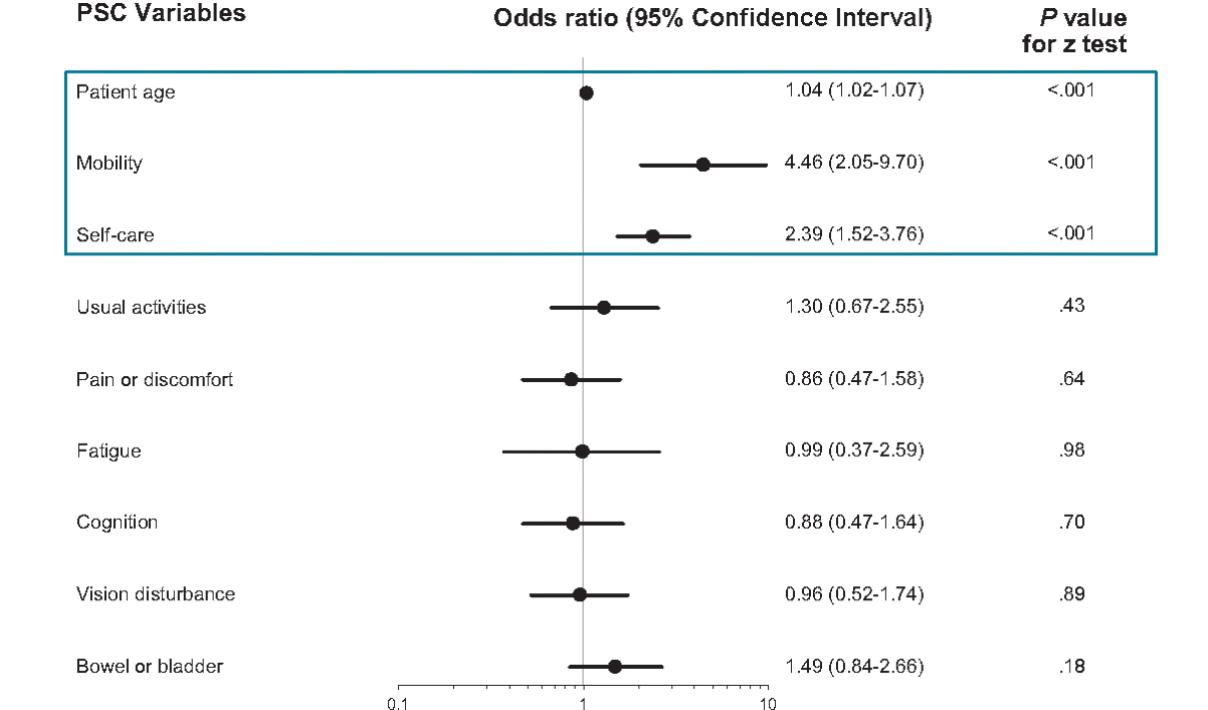
Figure 3. Multivariate regression analysis: patient self-completion form variable. An odds ratio >1 implies a higher risk of secondary progressive multiple sclerosis; the blue box highlights the significant predictors. PSC: patient self-completion. Black dots indicate odds ratio (point estimate); black line indicates the 95% confidence